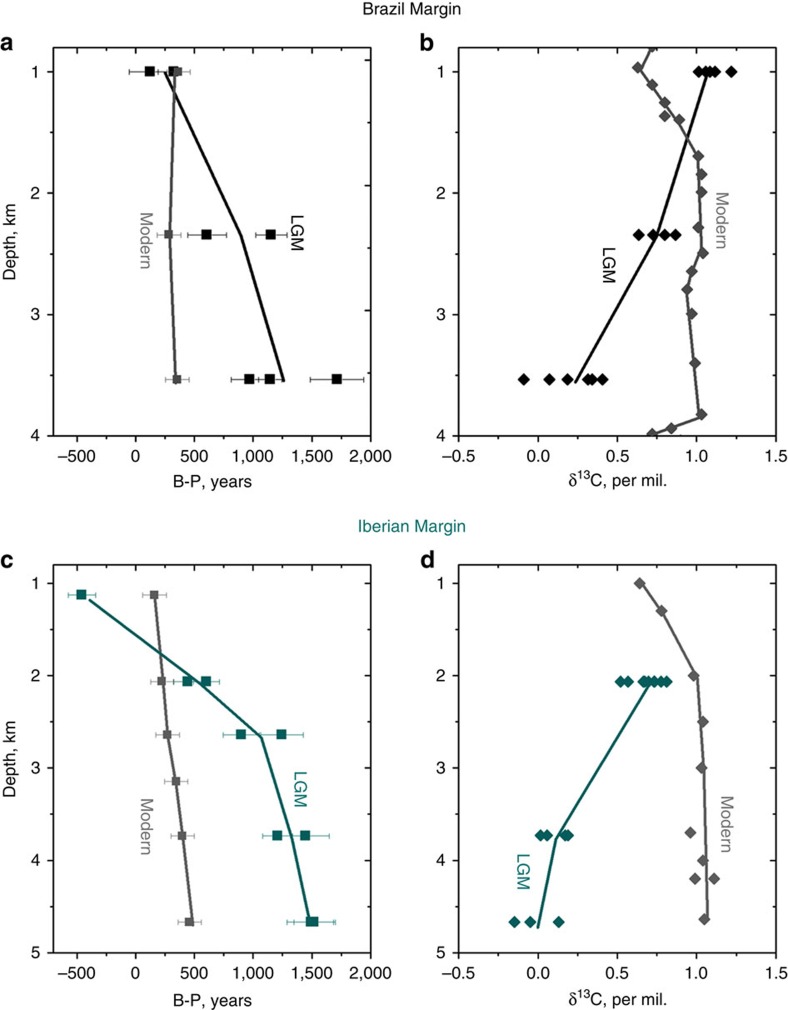
LGM depth profiles for the Brazil Margin and the Iberian Margin.The benthic-planktonic radiocarbon age offset (B-P; a, c) and the stable carbon isotopic ratio, δ13C (b, d). Modern B-P values (calculated by subtracting the modern surface reservoir age from the bottom water ventilation age) are show in grey (GLODAP38). Modern δ13C of DIC is also shown in grey (GEOSECS38). Data are given in Supplementary Table 3.